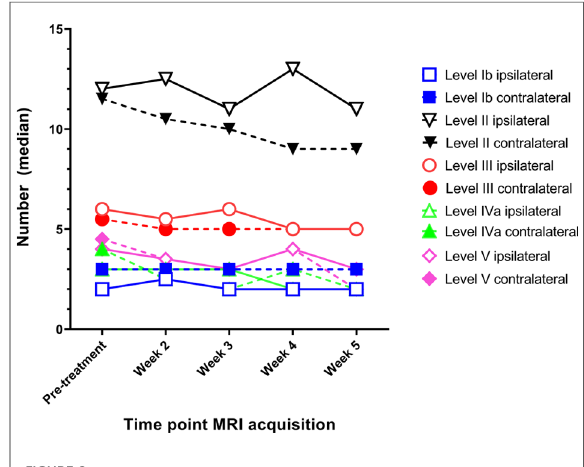
FIGURE 2 The median number of elective lymph nodes per lymph node level (IB to V) on both the ipsilateral and contralateral side for head and neck cancer patients during the course of radiotherapy.